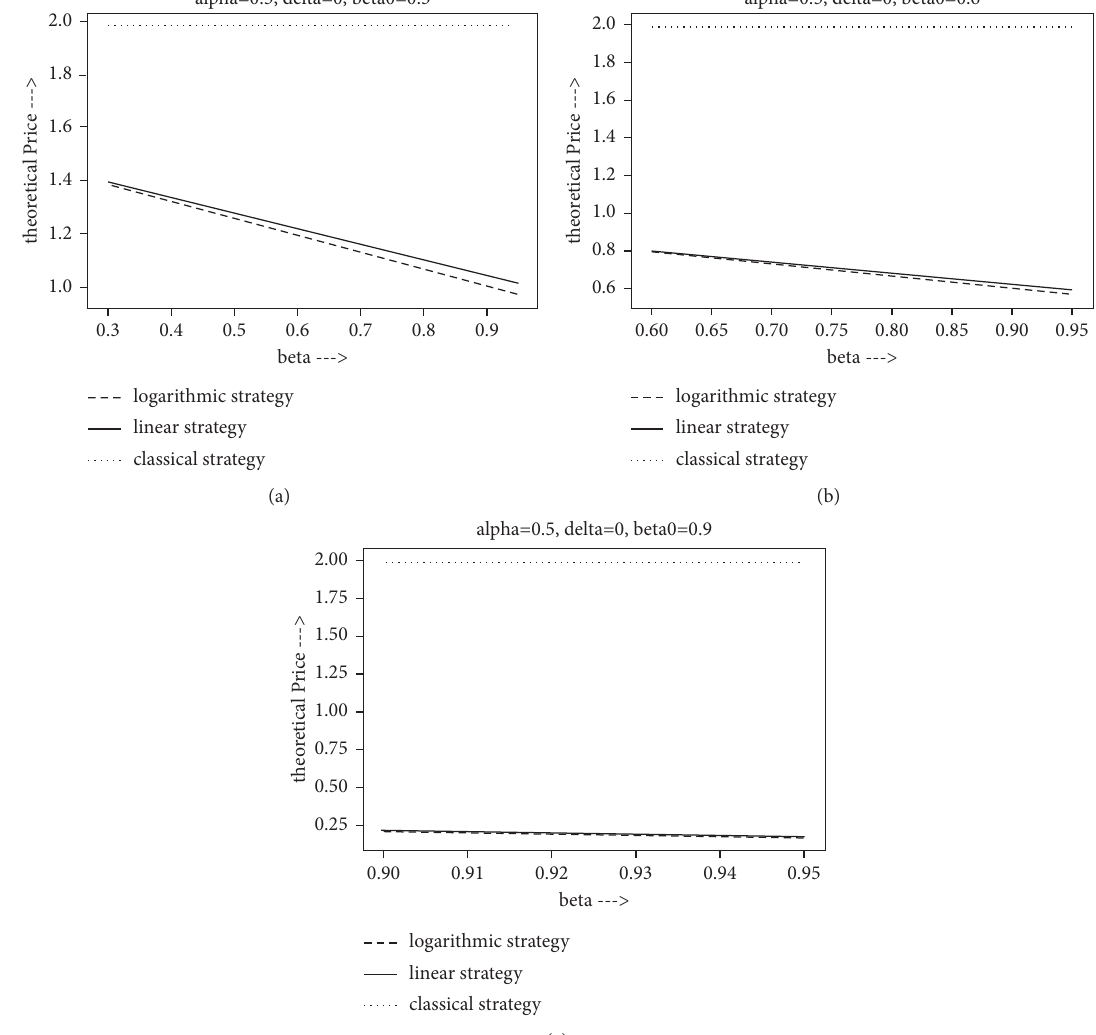
� 0.3, 0.6, or 0.9 (a, b, c), 0